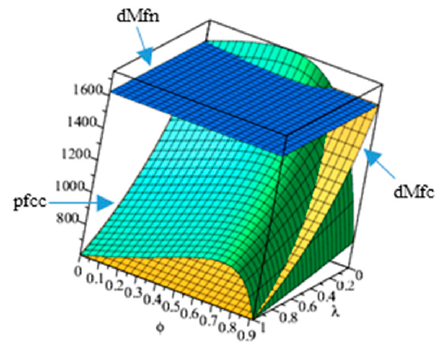
Figure 9. Effects of M’s fairness concerns on R’s profit degree.